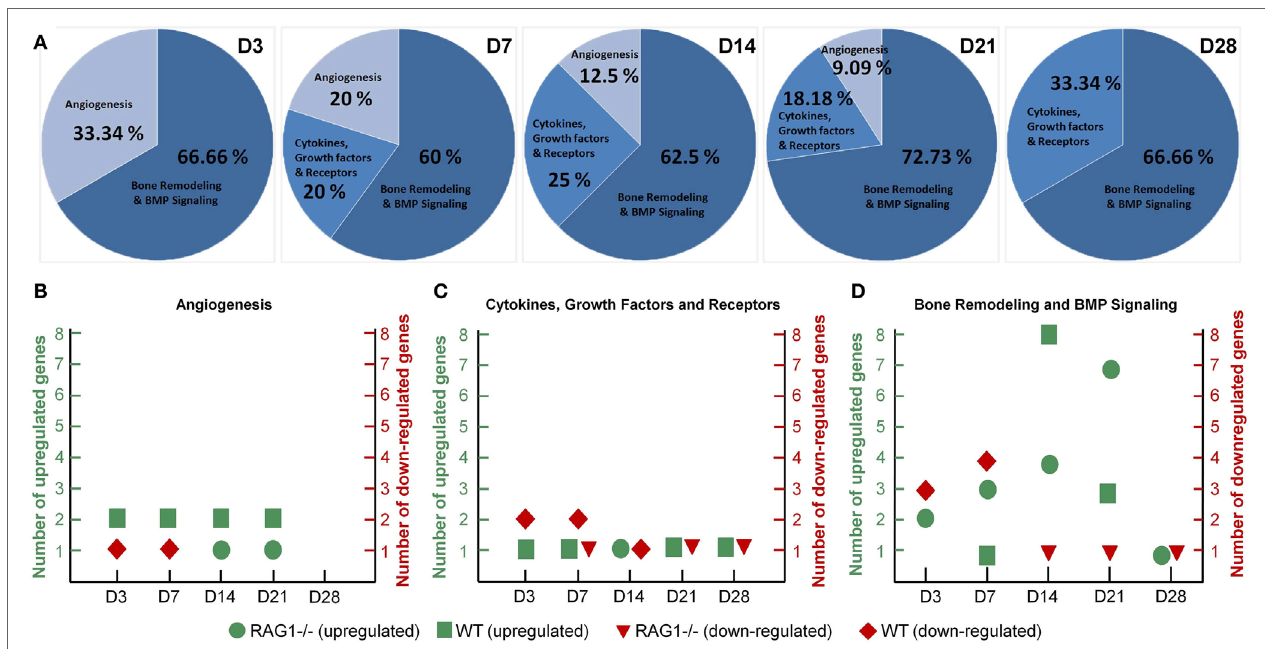
FigUre 7 | Dysregulated angiogenesis and cytokine expression in the recombination activating gene 1 homozygous knockout (rag1 − / − ) callus along with chronically shifted (earlier) bone formation and remodeling . (a) Angiogenesis-related genes showed declining numbers of differentially expressed genes with healing progression in the RAG1 − / − . Cytokines and growth factor gene expression was highest at day 28 (D28). Interestingly, the percentage of bone remodeling and formation differentially expressed genes was almost constant throughout the healing in the RAG1 − / − fracture callus. (B) Mostly, wild-type (WT) genes were upregulated at all time points, whereas upregulation in the RAG1 − / − was only at D14 and D21. (c) RAG1 − / − genes were upregulated only at D14. (D) Number of upregulated genes in the RAG1 − / − increased from D3 to D14, however, at D28 upregulated genes were still seen in the RAG1 − / −